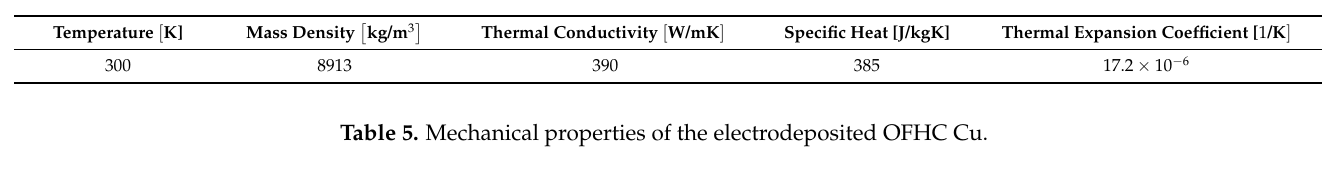
Table 4. Physical properties of electrodeposited OFHC Cu.